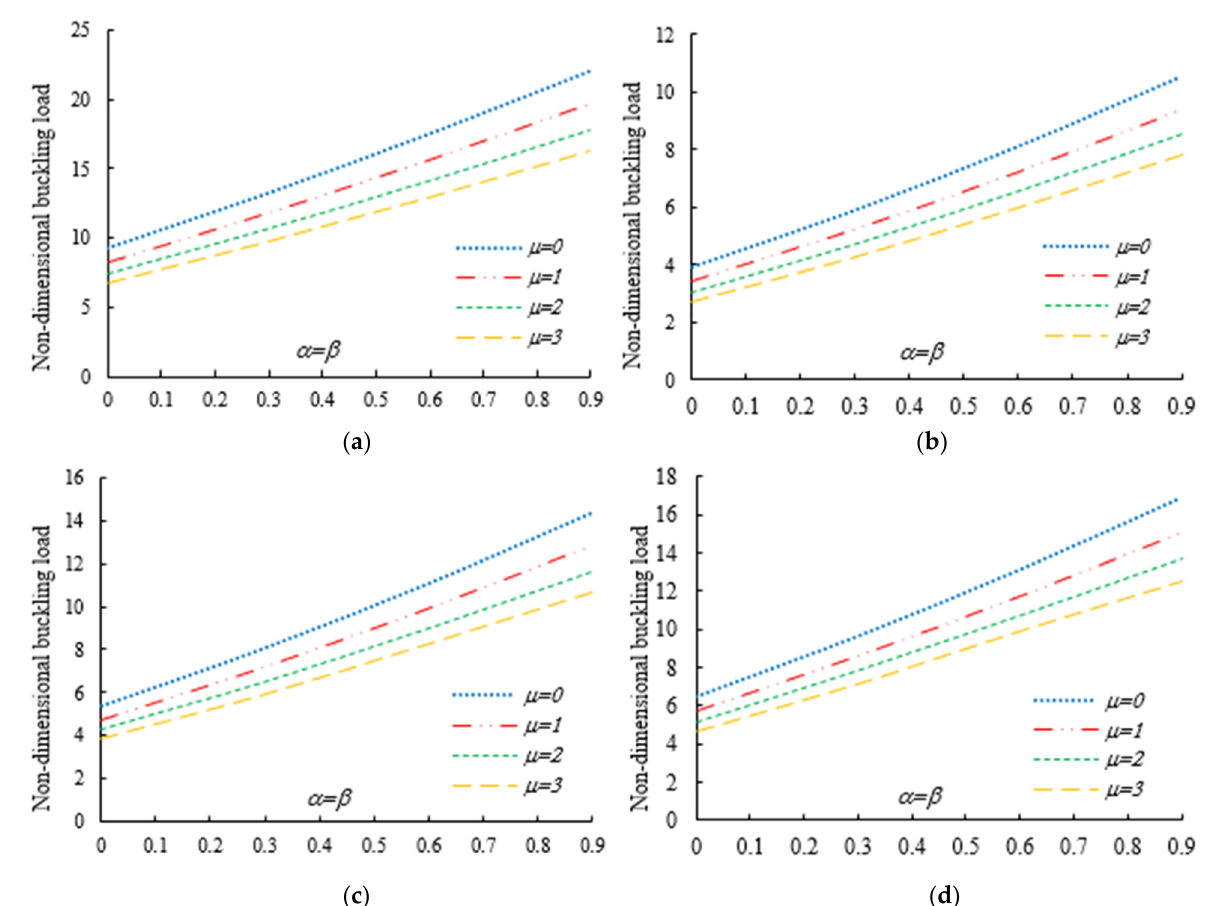
Figure 4. Variation in the flexural buckling load nonlocality parameters for different material indexes (axial load on the centroid) ( a ) Homogeneous (Alumina) ; ( b ) 0.6 m =